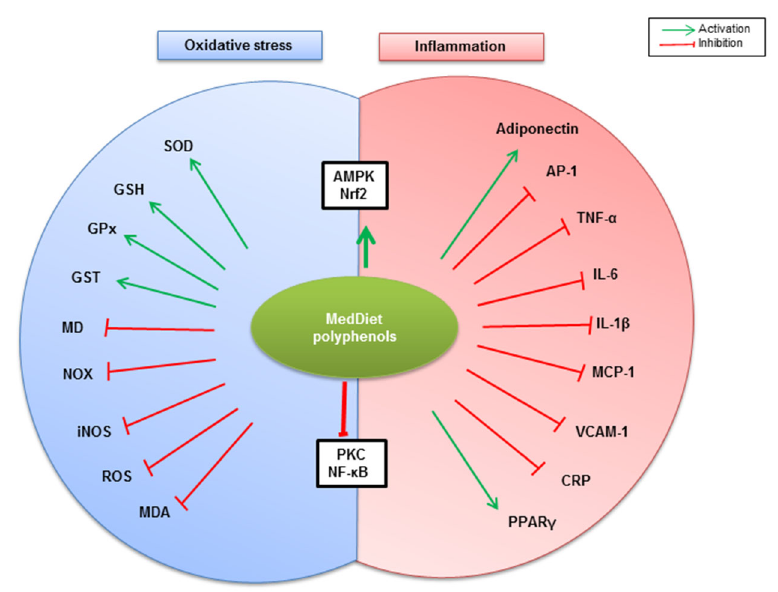
Figure 3. Summary of potential mechanisms by which MedDiet polyphenols modulate oxidative stress and inflammation associated with obesity. MedDiet polyphenols potentiate both AMPK- and Nrf2-mediated anti-inflammatory and antioxidant pathways, reflected by anti-inflammatory adiponectin, PPAR γ , and endogenous antioxidants (SOD, GSH, GPx, and GST) upregulation. On the other hand, PKC and NF- κ B-dependent inflammation and oxidative stress are counteracted by MedDiet polyphenols, reflected by the downregulation of pro-inflammatory molecules (AP-1, TNF- α , IL-6, IL-1 β , MCP-1, VCAM-1, and CRP), and oxidative stress mediators and operators (MD, NOX, iNOS, ROS,